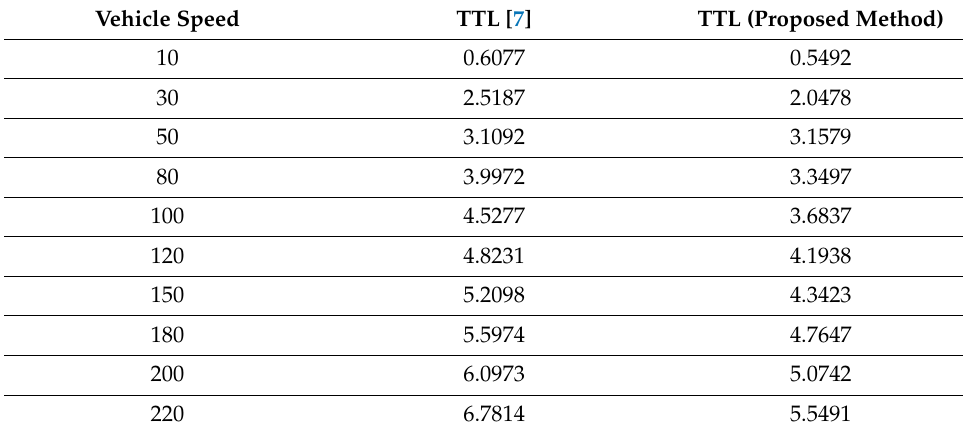
Table 6. Time to Live (TTL), in